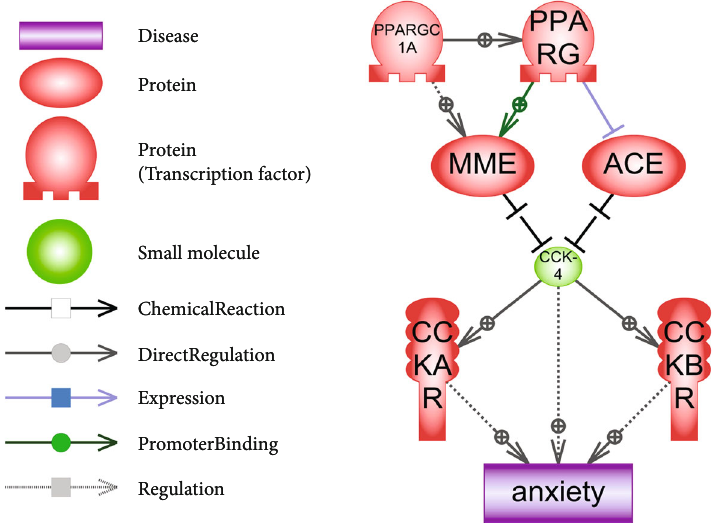
Figure 5: Hypothetical signaling pathway for PPARG in the regulation of anxiety. Legend in the fi